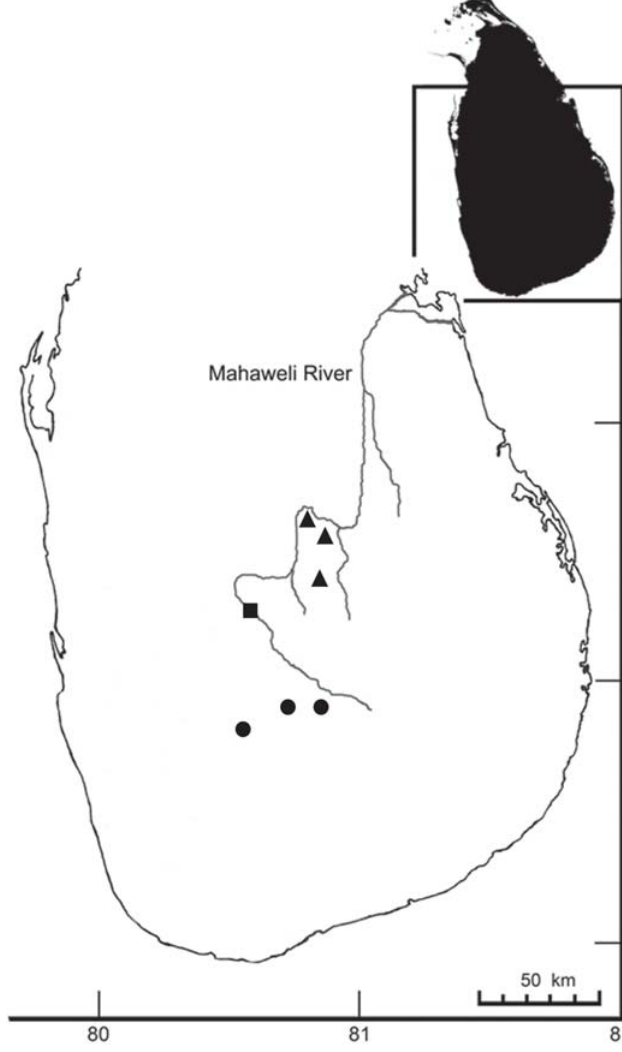
Figure 5. Distribution of C. liocephalus populations - Central-hill population; - Knuckles population, - Type